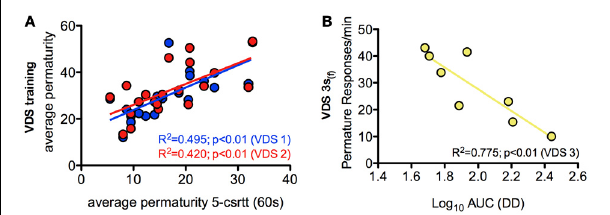
FIGURE 4 | Relevant correlations between 5-csrtt and DD performances and the VDS. (A) The average number of premature responses in the 60s stage of the 5-csrtt correlated with the number of premature responses of both VDS 1 and VDS 2 training periods. (B) Preference for delayed choices (as measured by the AUC) in DD was inversely correlated with premature responses in the 3s (f) period of the VDS. See Table 1 for complete analyses. 5-csrtt—5 choice serial reaction time task; AUC—area under the curve; DD—delay discounting; VDS—variable delay-to-signal